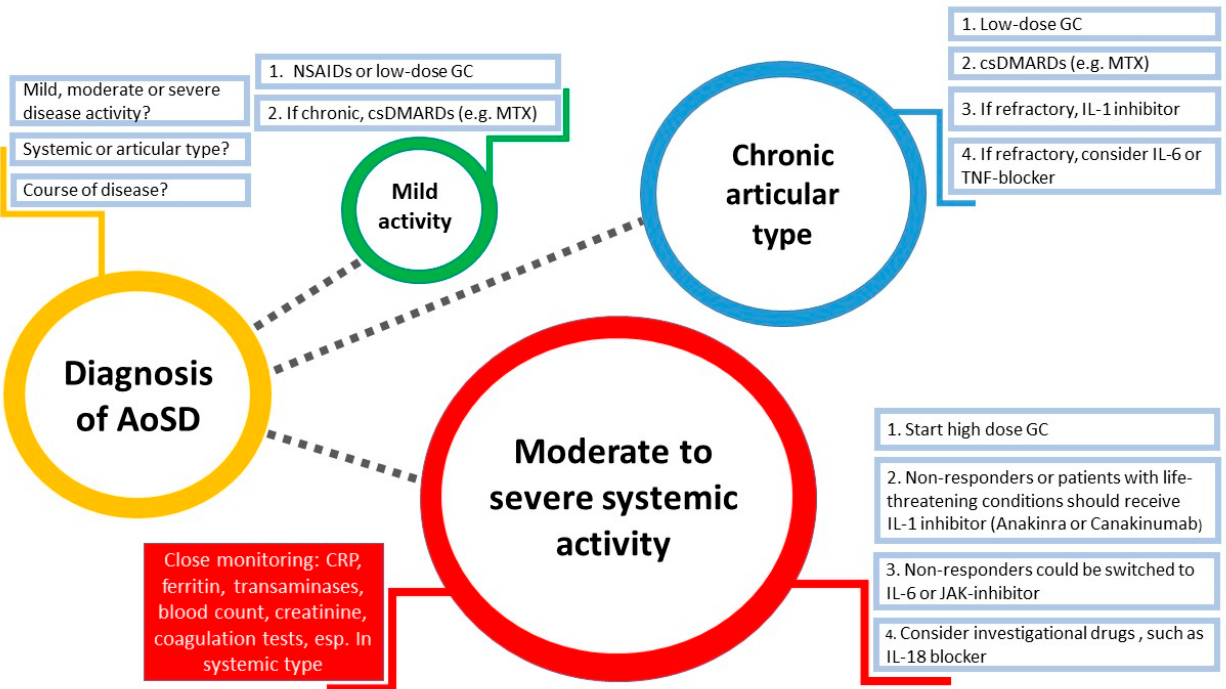
Figure 1. Suggested strategy for management of AoSD. Diameter of the circles represents the challenge in clinical practice. AoSD = Adult-onset Still’s disease, NSAIDs = Non-steroidal anti-inflammatory drugs, MTX = Methotrexate, csDMARDs = Conventional synthetic disease-modifying antirheumatic drugs, IL = Interleukin, TNF = Tumor necrosis factor, JAK = Janus kinase, GC = Glucocorticoids, CRP = C-reactive protein.